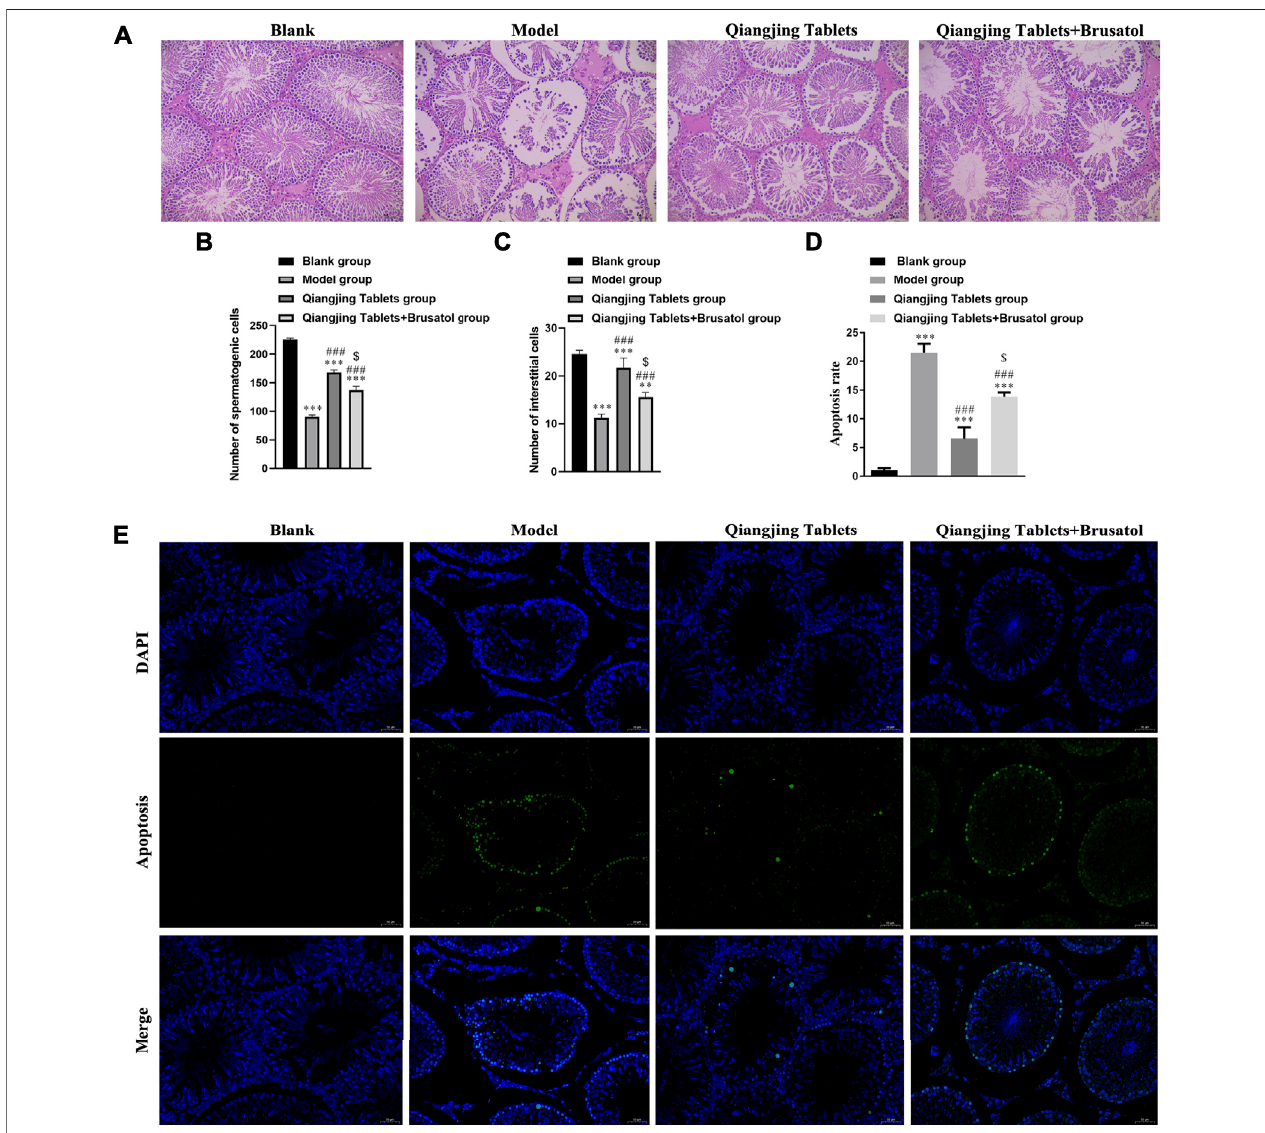
FIGURE4| EffectonmorphologyintestisinducedbyQiangjingTabletsinAZSrats. (A – C) HandEstainingtoshowhistopathologicalchangesinthetestisinBlank, model,QiangjingTabletsandQiangjingTablets+Brusatolgroups(originalmagnifcation × 200;scalebar,10 μ m).Red:spermatogenic cells:green:interstitialcells:blue: seminiferous tubule. (D – E) Green is apoptotic cells by Tunel in Blank, model, Qiangjing Tablets and Qiangjing Tablets + Brusatol groups (original magni fi cation, 400 × ). Valuesareexpressedasmean ± SD, n (cid:2) 15pergroup.** p < 0.01 vs .Blankgroup;*** p < 0.001 vs Blankgroup;## p < 0.01VSmodelgroup;### p < 0.001 vs model group; $ p < 0.05 vs Qiangjing Tablets